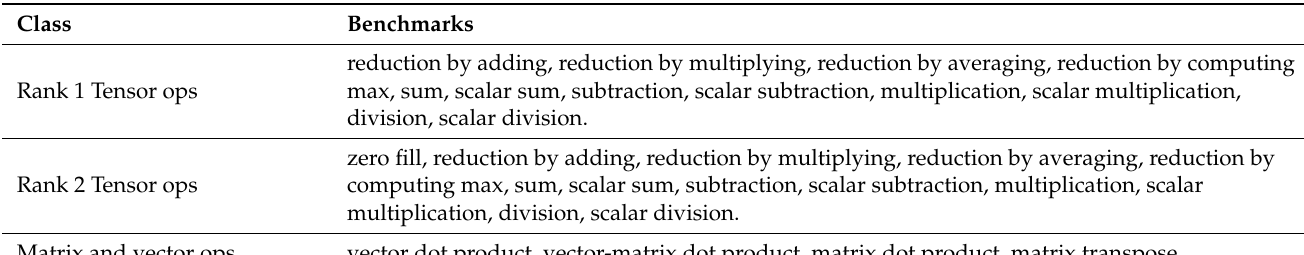
Table 7. Characteristics of the benchmark